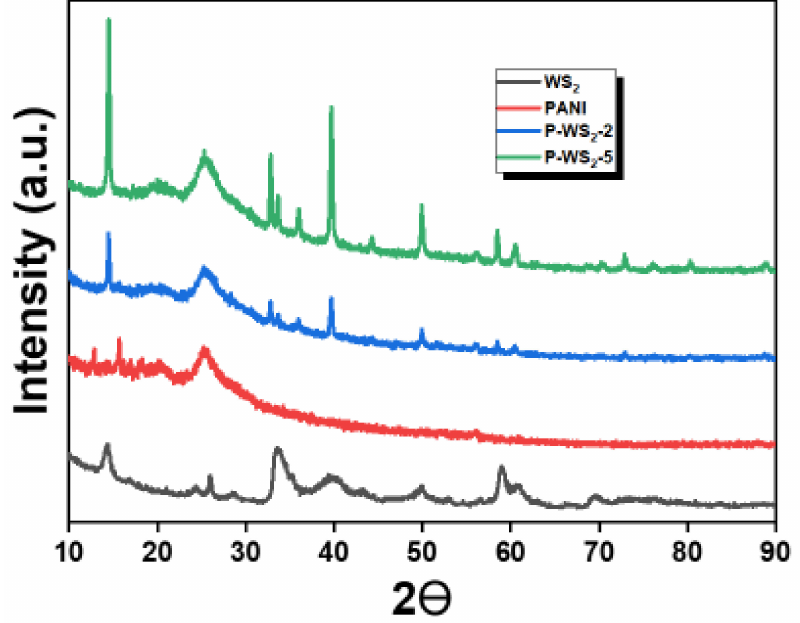
Figure 6. XRD spectra for WS 2 , PANI, WS 2 -PANI-2, and WS 2